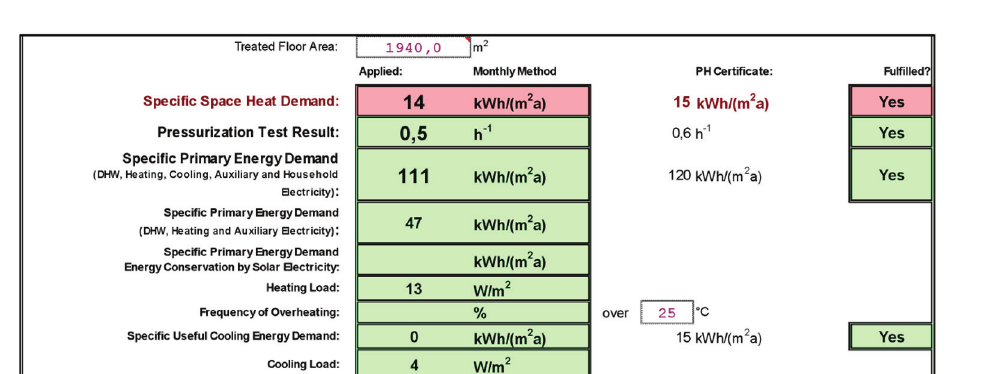
Fig. 3. input data window